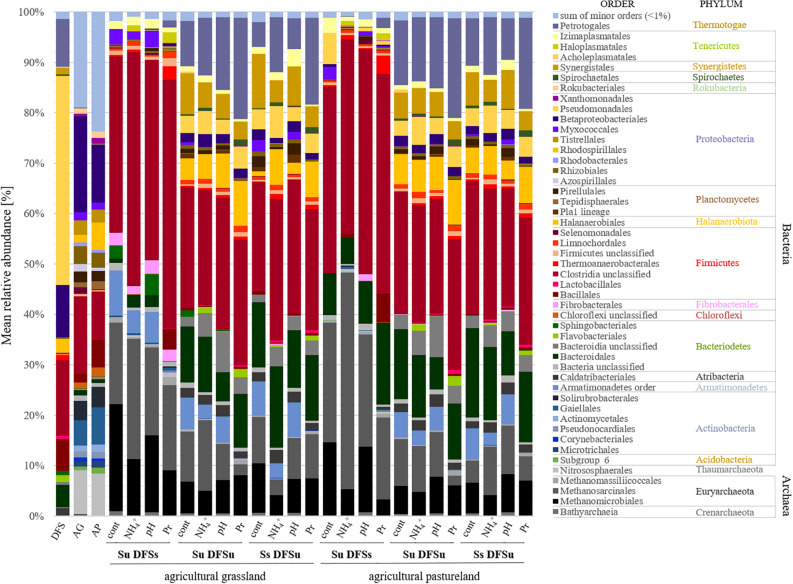
Mean relative abundance [%] of prokaryotic communities at order (and phylum) level depending on different inoculations and stress variations (n = 3). DFS, diluted fermenter sludge; AG, agricultural grassland; AP, agricultural pastureland; cont, controls; Pr, propionate; Su, soil unsterile; Ss, soil sterile; DFSu, diluted fermenter sludge unsterile, DFSs, diluted fermenter sludge sterile.